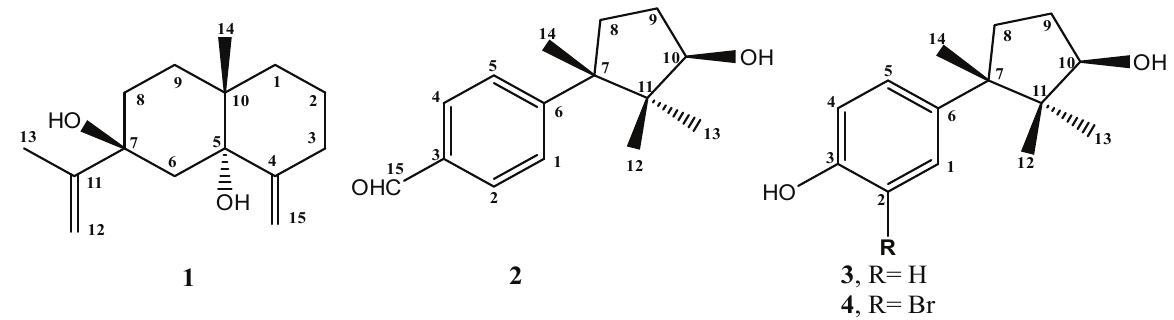
Figure 1: Structure of compounds 1‒4